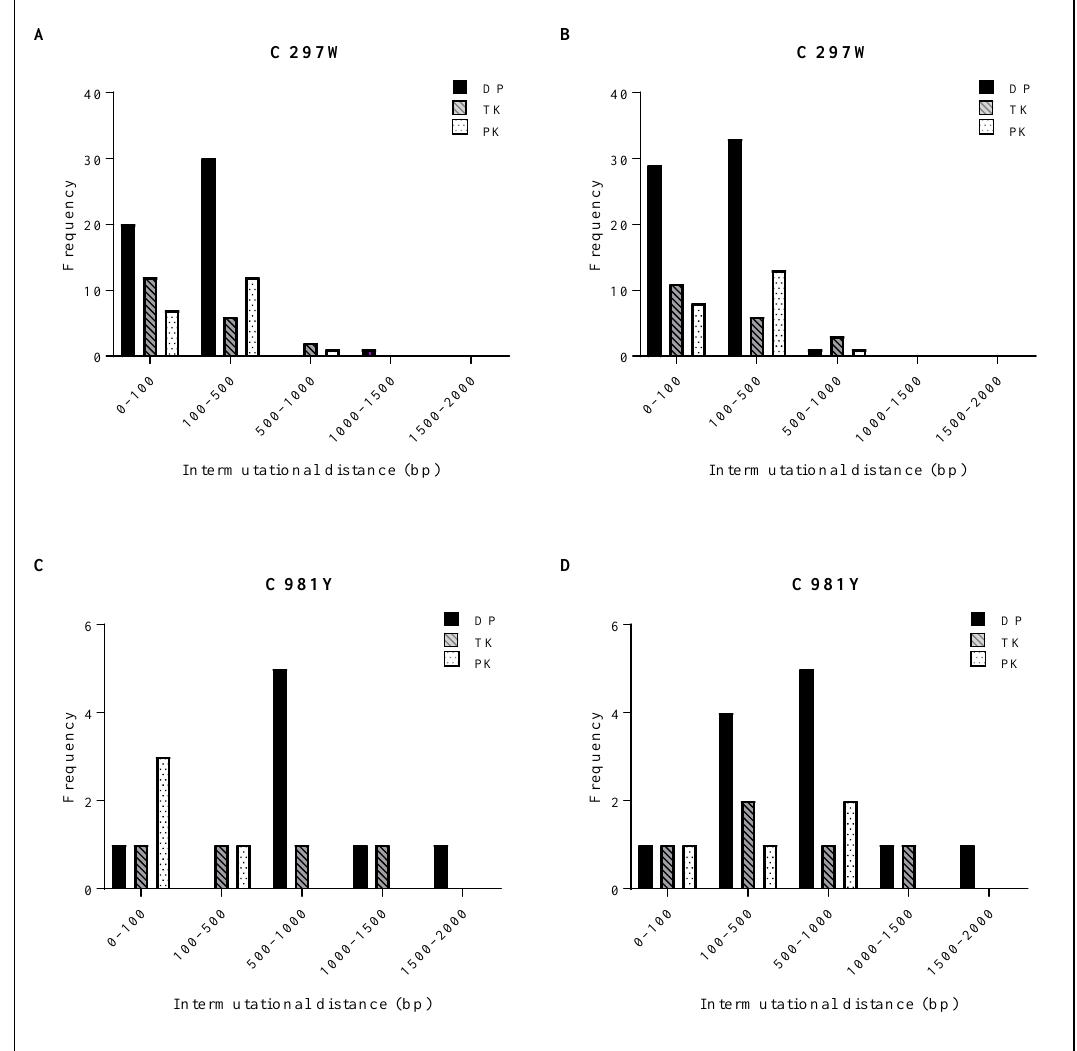
Figure 5. Distribution of the intermutational distance in the viral PK, TK and DP of C297W and C981Y. For both C297W and C981Y, next-generation sequencing of the viral DP, TK and PK was performed on three viral clones at two different points of expansion (i.e., three clones #0 and three clones #3). ( A ) Intermutational distance of 3 viral clones bearing C297W amino acid change without amplification. ( B ) Intermutational distance of 3 viral clones bearing C297W amino acid change after 3 rounds of amplification. ( C ) Intermutational distance of 3 viral clones bearing C981Y amino acid change without amplification. ( D ) Intermutational distance of 3 viral clones bearing C981Y amino acid change after 3 rounds of amplification.